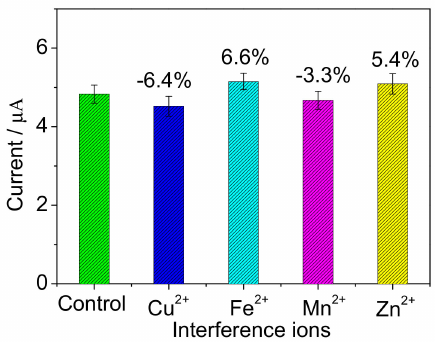
Figure 13. Interference of some heavy metal ions on the biosensor response to 10 mg/L BOD. The error bars represent three replicate measurements.